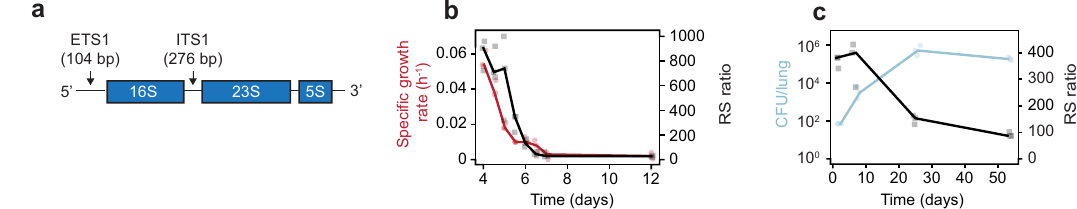
Fig. 1 RS ratio correlates with Mtb replication. a Mtb ribosomal operon. b The RS ratio (black) mirrored speci fi c growth rate (red) in an in vitro progressive oxygen depletion model. Dots represent values from three independent experiments. Lines connect median values. c In the BALB/c chronic infection model, the lung Mtb CFU burden (blue) rose rapidly and then plateaued over time. The RS ratio (black) indicated rapid initial rRNA synthesis that slowed as Mtb burden plateaued. Dots represent values from three individual mice. Lines connect mean values from each timepoint. Source data are provided as a Source Data fi